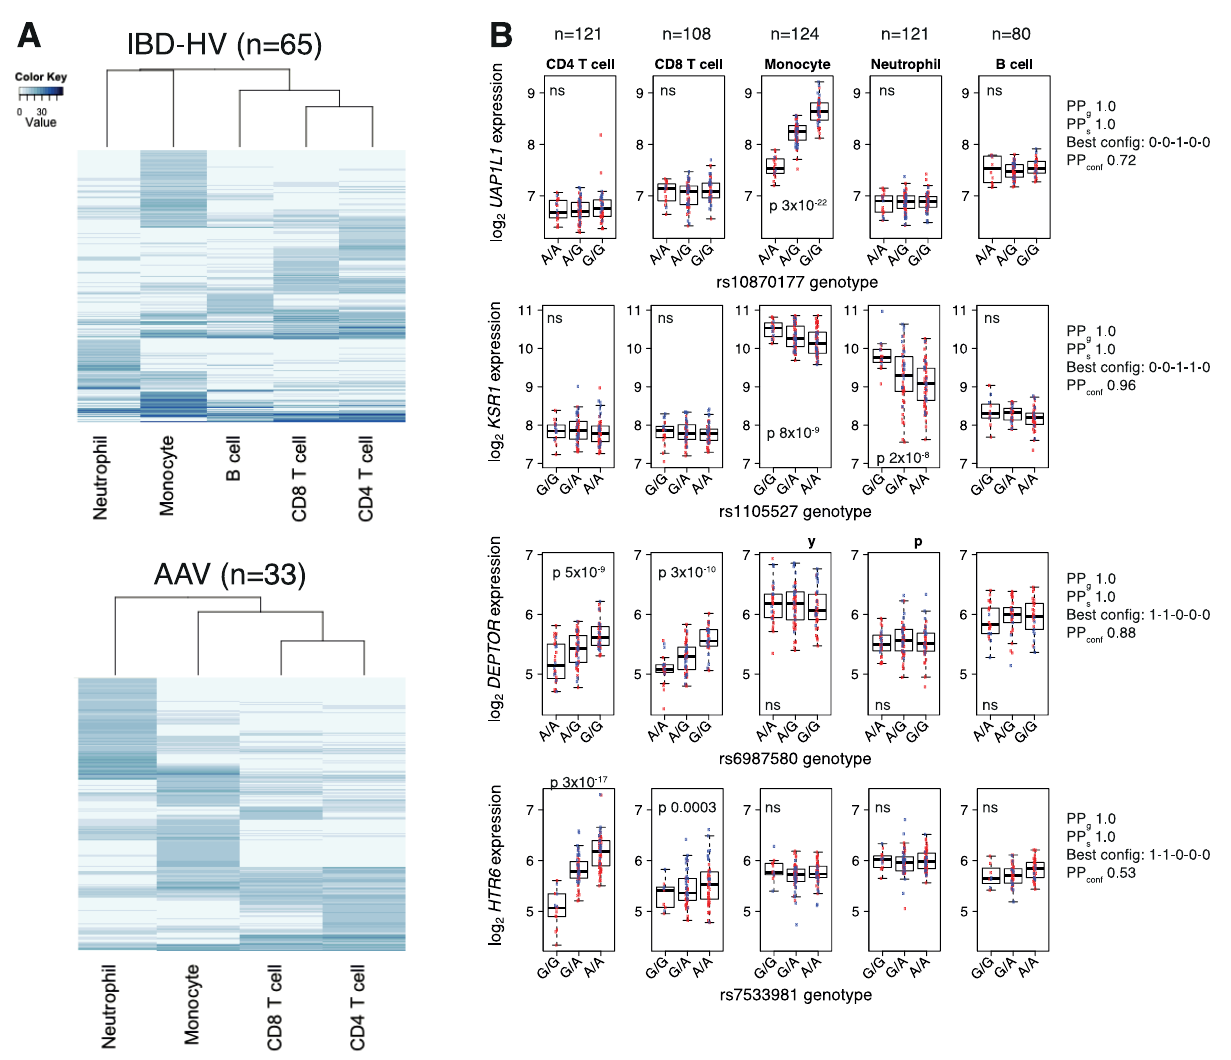
Fig 2. eQTL sharing is related to haematopoietic lineage. (A) Heatmap representation of the matrix of association statistics (chi-squared scores) from one-at-a-time cell-type cis eQTL scans using PEER-adjusted expression data. Rows are SNP-gene pairs, columns are cell types, and the association statistic (chi-squared score) is represented by the shading in the colour key. The stronger the association the darker the blue shading. Rows and columns have both been hierarchically clustered. Analysis has been limited to the set of individuals with complete expression data across cell types to ensure equal statistical power (5 and 4 cell types in the IBD-HV and AAV analyses respectively). (B) Examples of cell- and lineage-specific eQTLs. From top: monocyte- specific, myeloid-specific, and two T lymphocyte-specific eQTLs. For ease of biological interpretation, here we show RMA-normalised expression values before adjustment for batch, sex and latent factors with PEER. Boxplots indicate median, and upper and lower quartiles. For PEER-adjusted values, see S4 Fig. Blue and red dots represent HV and IBD respectively. P-values are from association using PEER-adjusted data. ns = not significant. PP g = posterior probability that the gene has at least one eQTL in at least one cell type (joint cell type analysis with eQTLBMA). PP s = posterior probability that the SNP is an eQTL for the gene in at least one cell type, given that the gene has an eQTL. ‘ Best config ’ = best configuration of eQTL presence (1) / absence (0) across the 5 cell types. PP conf = posterior probability for the best